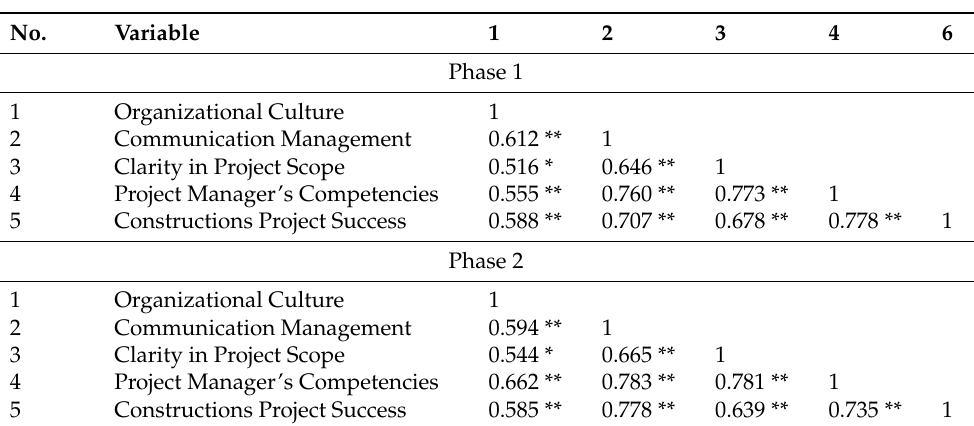
Table 8. Correlation